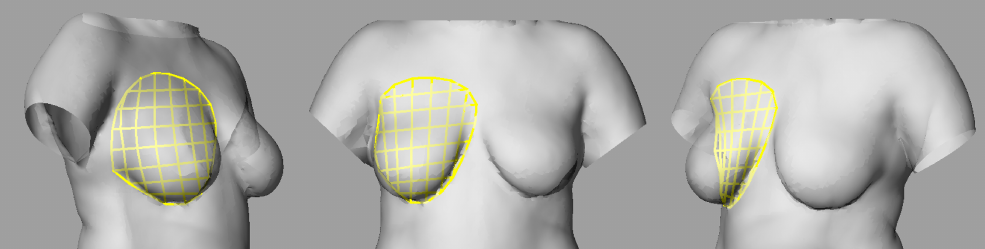
Figure 7. “Flat” initial breast grid for FDM.